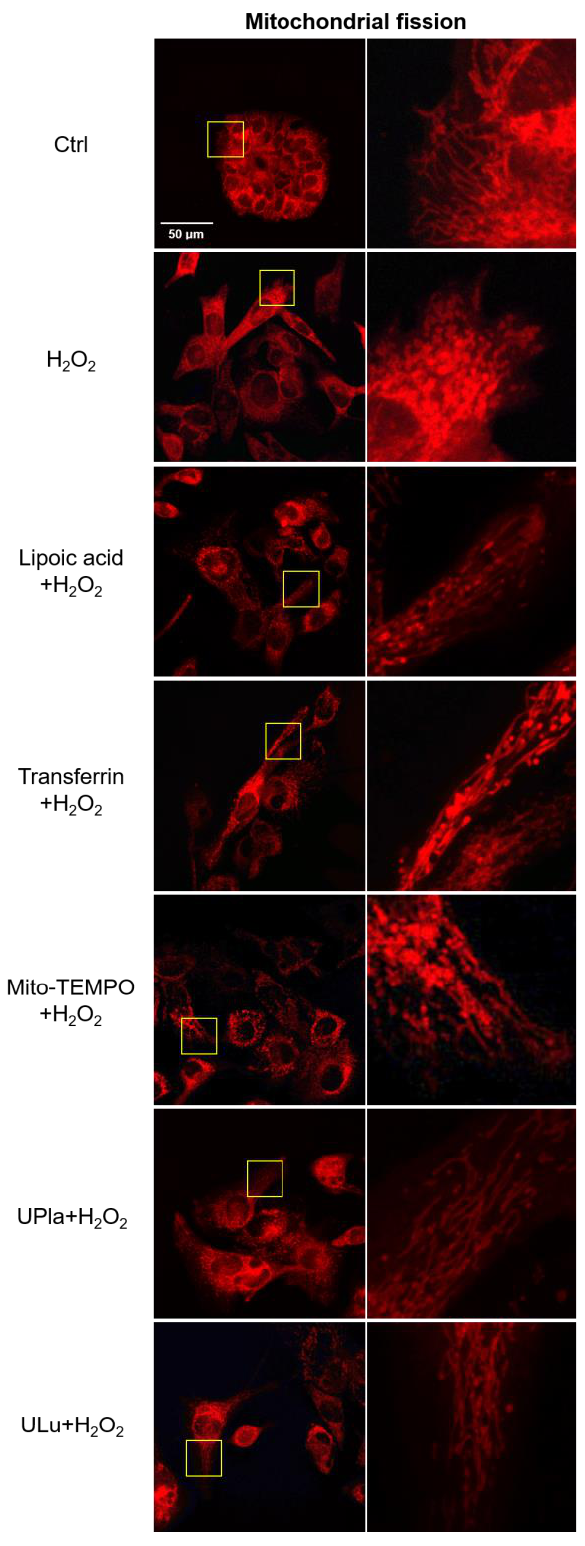
Figure 11. Mitochondrial fission was detected with the mitochondrial dye MitoTracker Red and viewed by confocal microscopy. On the right side, the areas in the rectangle (left column) are magnified. Spherical or fragmented mitochondria were regarded as undergoing fission. The images are representative of three independent experiments.